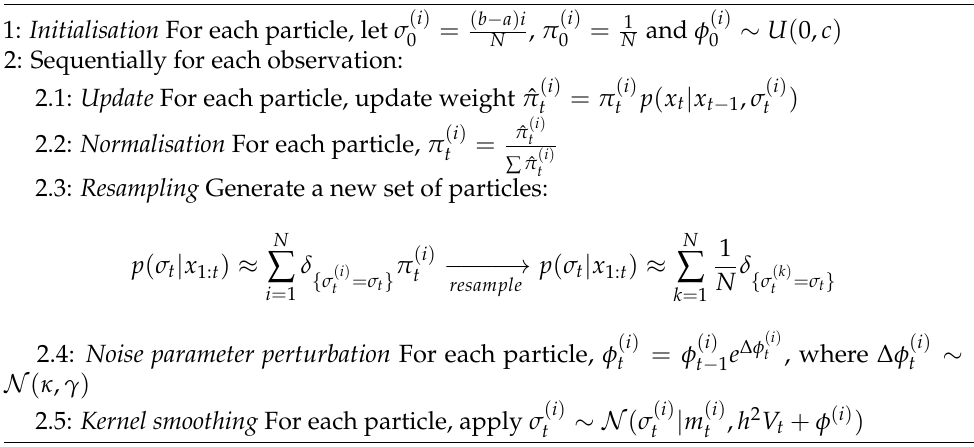
Algorithm 6 Filtering algorithm including a dampening factor on the rate of adaptation